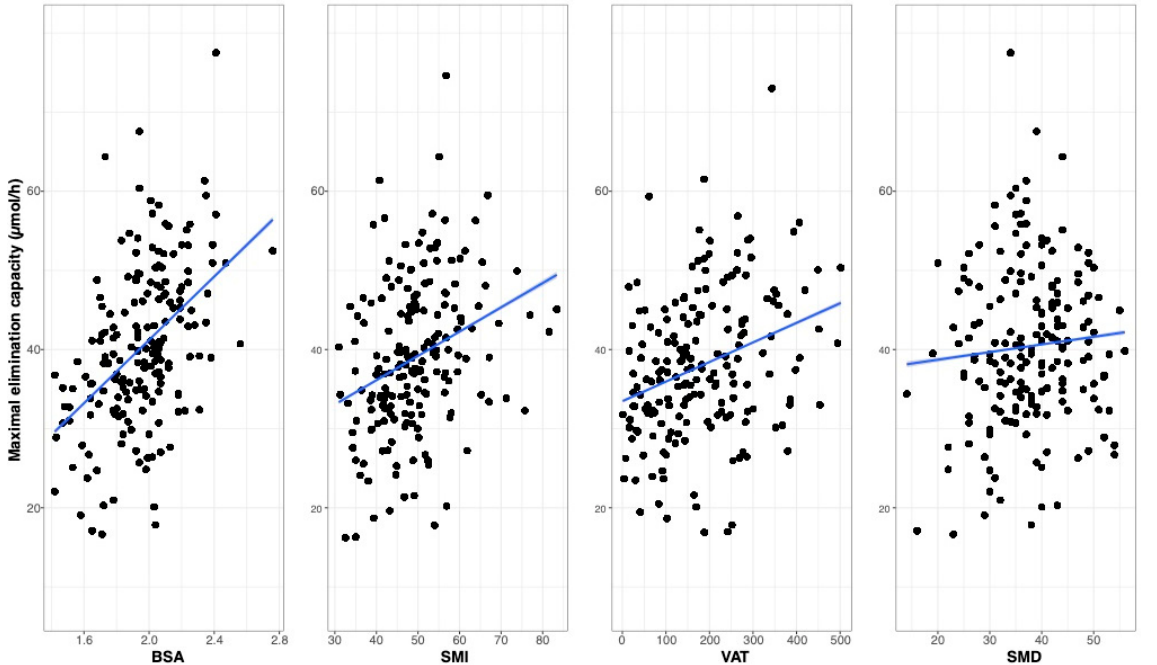
Figure 3. Data simulation of the impacts of BSA, SMI, VAT, and SMD on the maximal elimination capacity of paclitaxel.